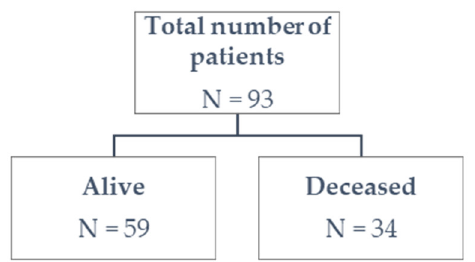
Figure 1. Flowchart of patients from the burn unit from January to December 2021.